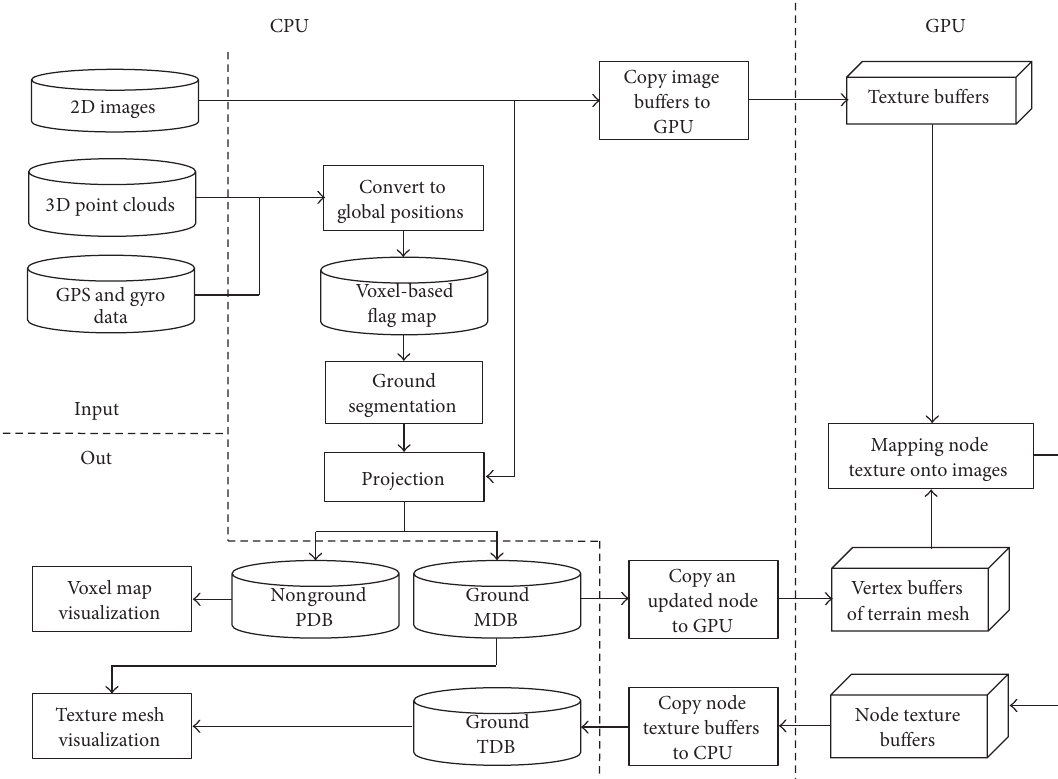
Figure 1: Framework of terrain storage generation